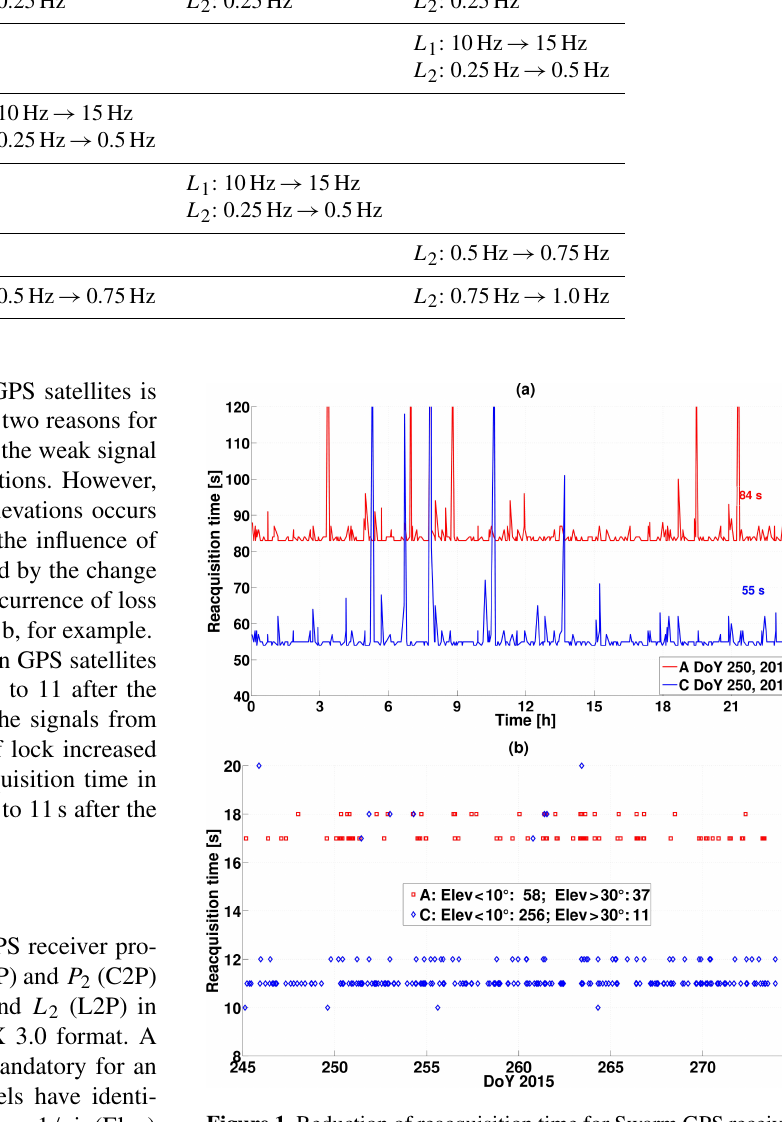
Figure 1. Reduction of reacquisition time for Swarm GPS receivers (a) due to setting and rising satellites on DoY 250, 2015 and (b) due to loss of lock in September 2015, red for Swarm A and blue for Swarm C with different tracking